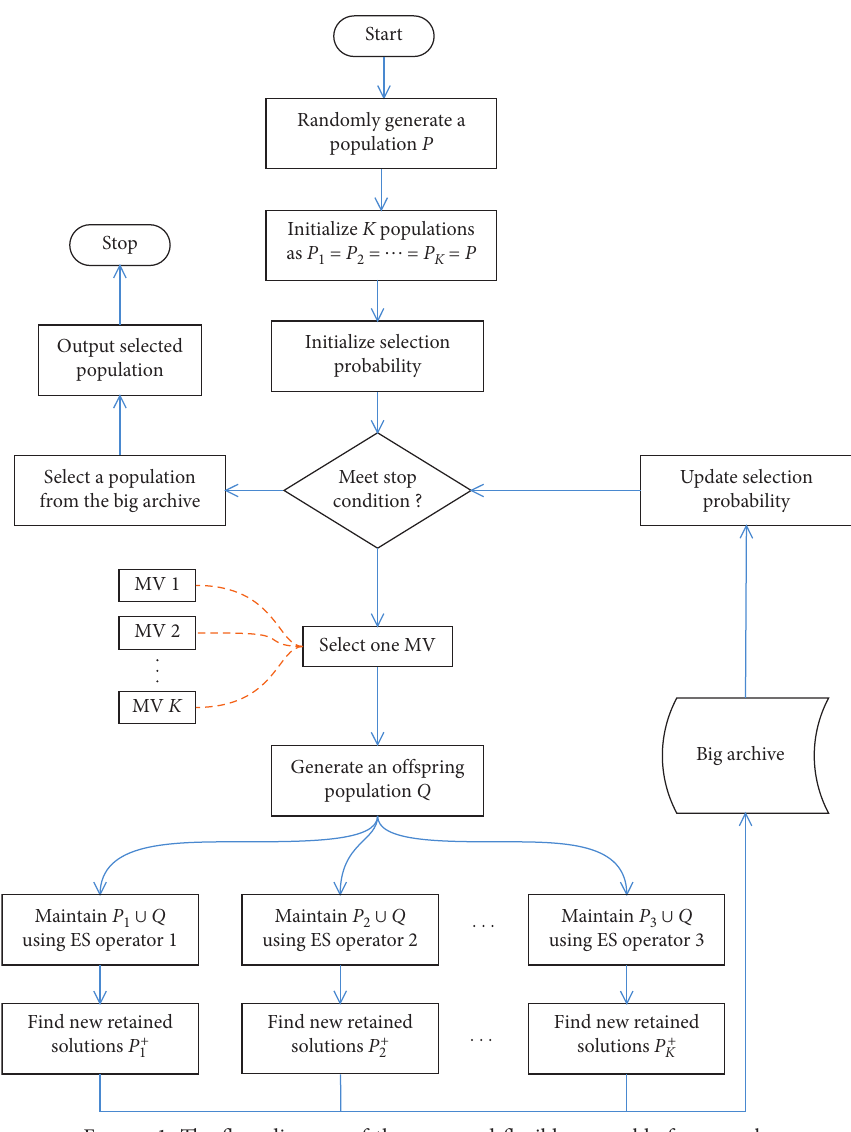
Figure 1: The flow diagram of the proposed flexible ensemble